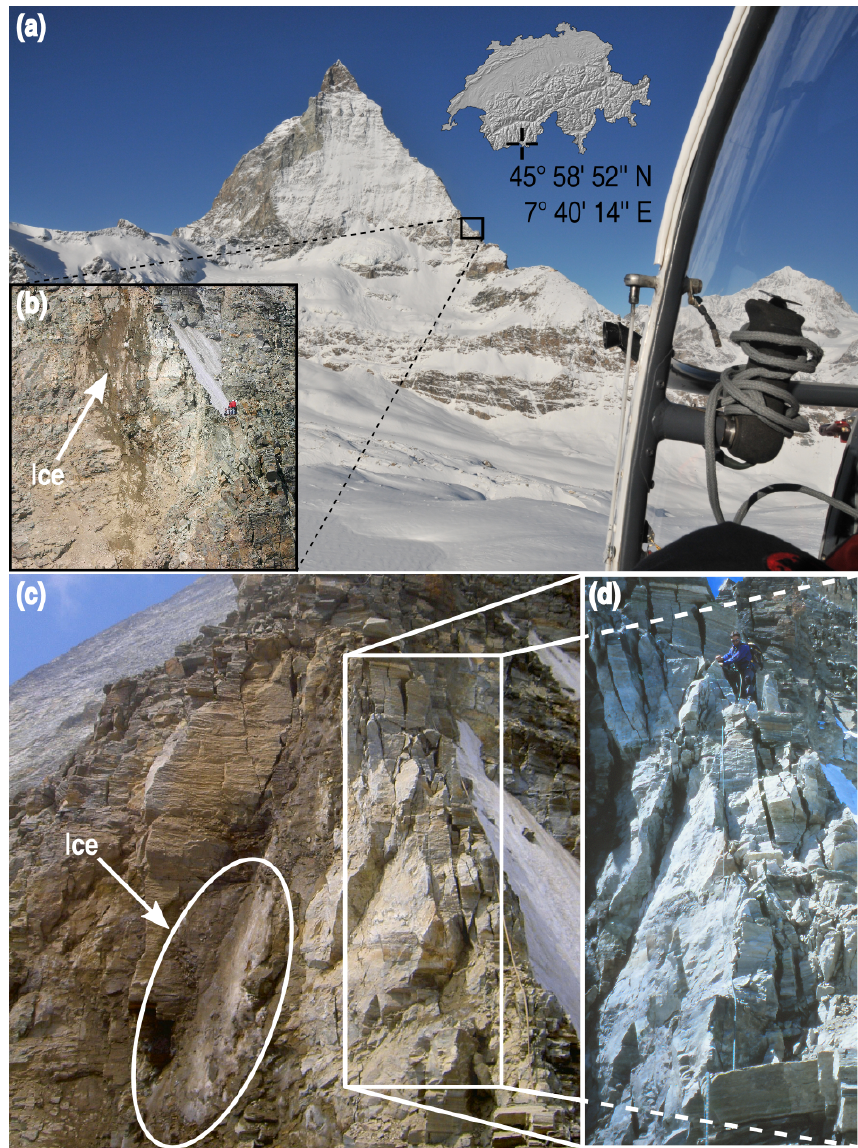
Figure 1. (a) The Matterhorn Hörnligrat field site is located on the northeastern ridge of the Matterhorn on 3500m a . s . l . (Swiss topography map based on © Google Earth and SRTM). (b) and (c) show the detachment zone after the rockfall event in July 2003 with a volume of approximately 1000–2000m 3 . The comparison between (c) and the detail (d) taken 2–5d before the rockfall event indicates that the top of the ridge was almost not affected by the failure event. Photos: PermaSense, Bruno Jelk and Kurt